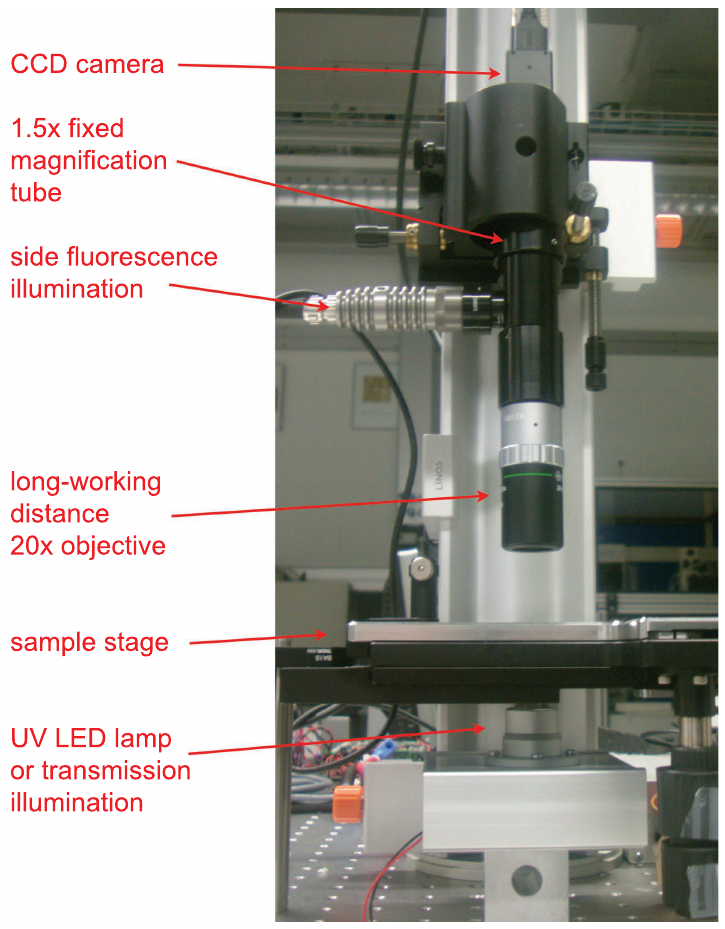
Figure 8. Image and description of the custom microscopy